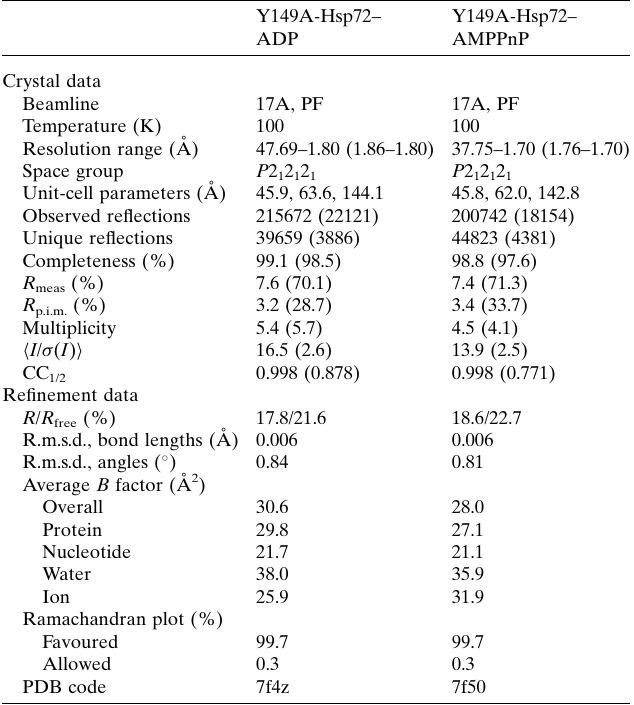
Table 1 X-ray diffraction data-collection and refinement statistics for the cryogenic Hsp72 crystals. Values in parentheses are for the outer